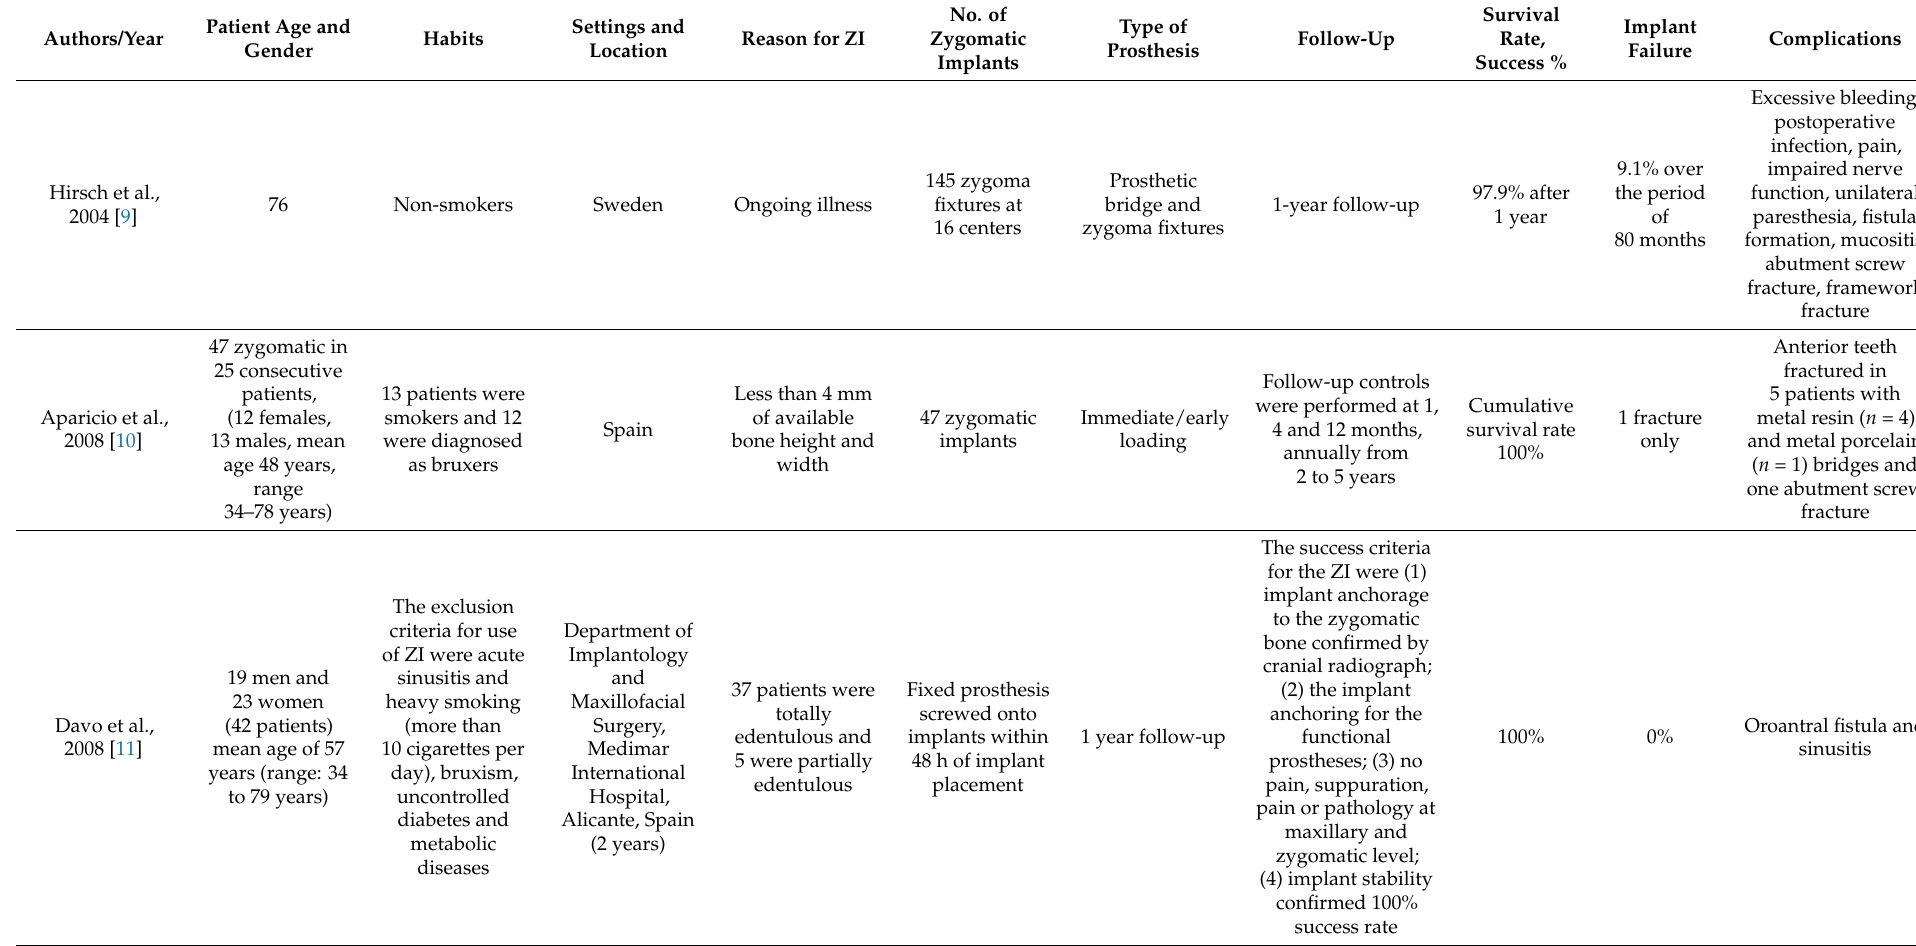
Table 1. General characteristics of the studies included for the evaluation . % of soft tissue dehiscence, rhino-sinusitis and prosthetic